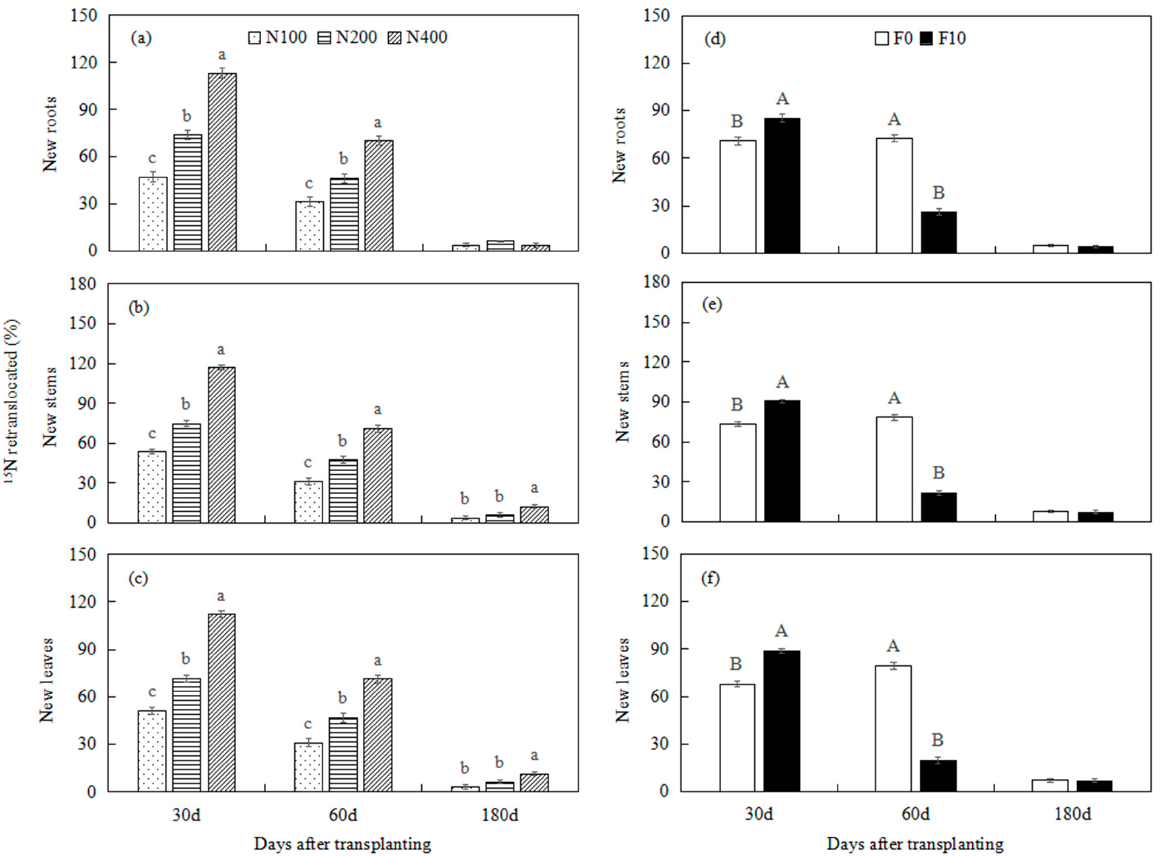
Figure 4. The main effects of nutrient loading (N) and fertilization at transplanting (F) on Betula alnoides 15 N retranslocated into new roots ( a , d ), new stems ( b , e ) and new leaves ( c , f ). Different letters represent significant differences among treatments within each sampling time at p < 0.05 according to Duncan’s multiple range test. Vertical bars are standard errors of the means (n = 6 or 9). See Table 3 for ANOVA summary.